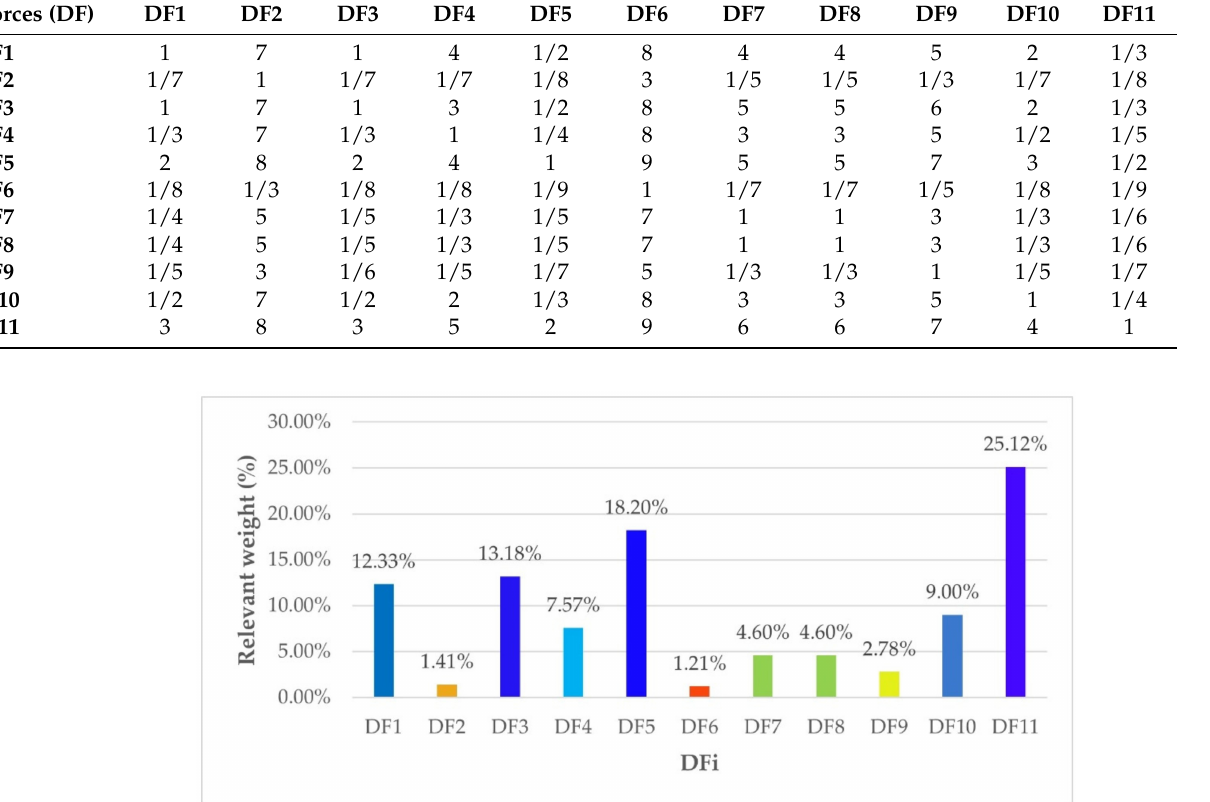
Table 2. Pairwise comparison matrix of driving forces DF1–DF11 with respect to the goal.